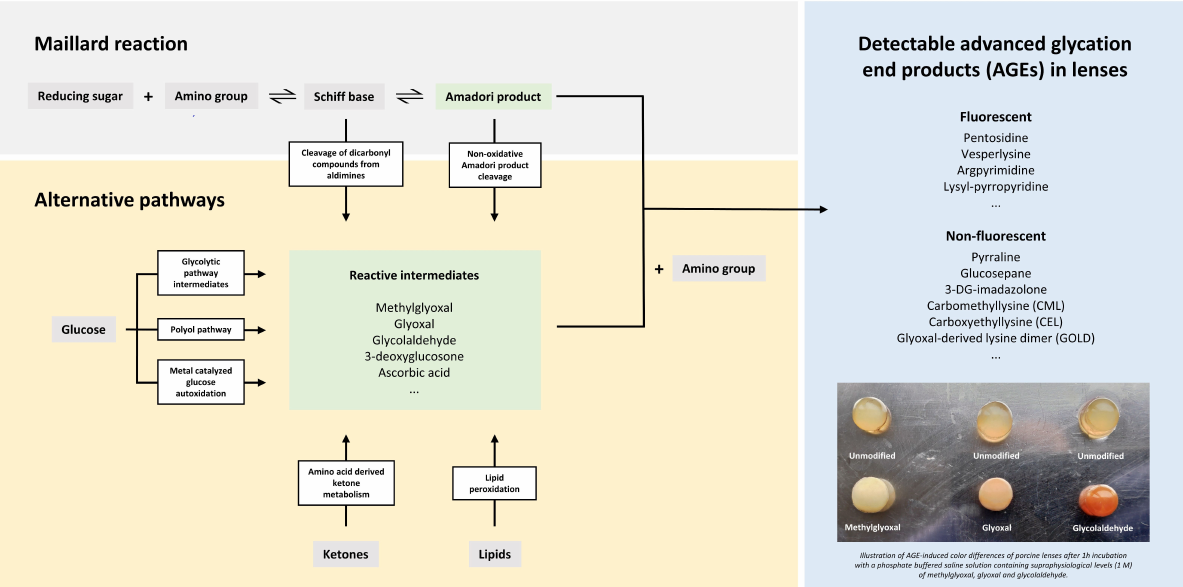
Figure 1. Advanced glycation end products (AGEs) are synthesized endogenously via the Maillard reaction and several alternative pathways [6]. In the early steps of the Maillard reaction, an iminine intermediate (Schiff base) is formed by the reaction of a reducing sugar (e.g., glucose) with a protein-bound amine or free amino acid. The labile Schiff base can produce highly reactive dicarbonyls (e.g., methylglyoxal) or rearrange into stable Amadori products. In the advanced steps of the Maillard reaction, the Amadori products undergo complex rearrangements, cleavage and covalent binding reactions, which eventually give rise to the generation of AGEs, which are stable adducts and cross-links of proteins [6,7]. Highly reactive carbonyls can also be generated from glycolytic pathway intermediates, the polyol pathway, glucose autoxidation, ketones generated by the breakdown of amino acids and lipid peroxidation. Those carbonyl compounds initiate the process of advanced glycation directly, eventually leading to the synthesis of a wide range of fluorescent (e.g., pentosidine) and non-fluorescent AGEs (e.g., glucosepane), which can be found in human tissues including eye lenses